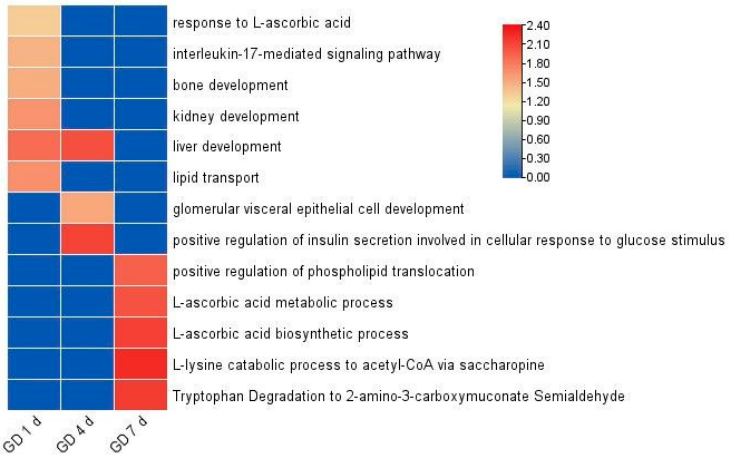
Figure 3. Biological pathways of differential proteins on GD 1 d, GD 4 d, and GD 7 d by analyzed GO.